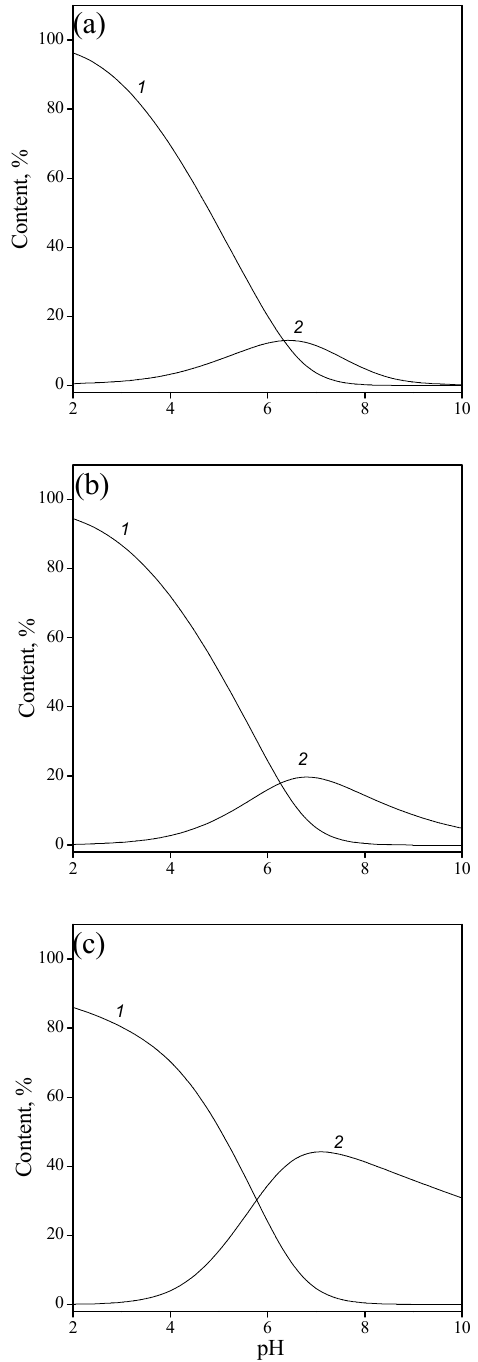
Figure 8. Surface speciation of adsorption complexes of IMP as a function of pH and ionic strength: 0.001 ( a ), 0.01 ( b ), and 0.1M NaCl ( c ); ≡ TiOH +